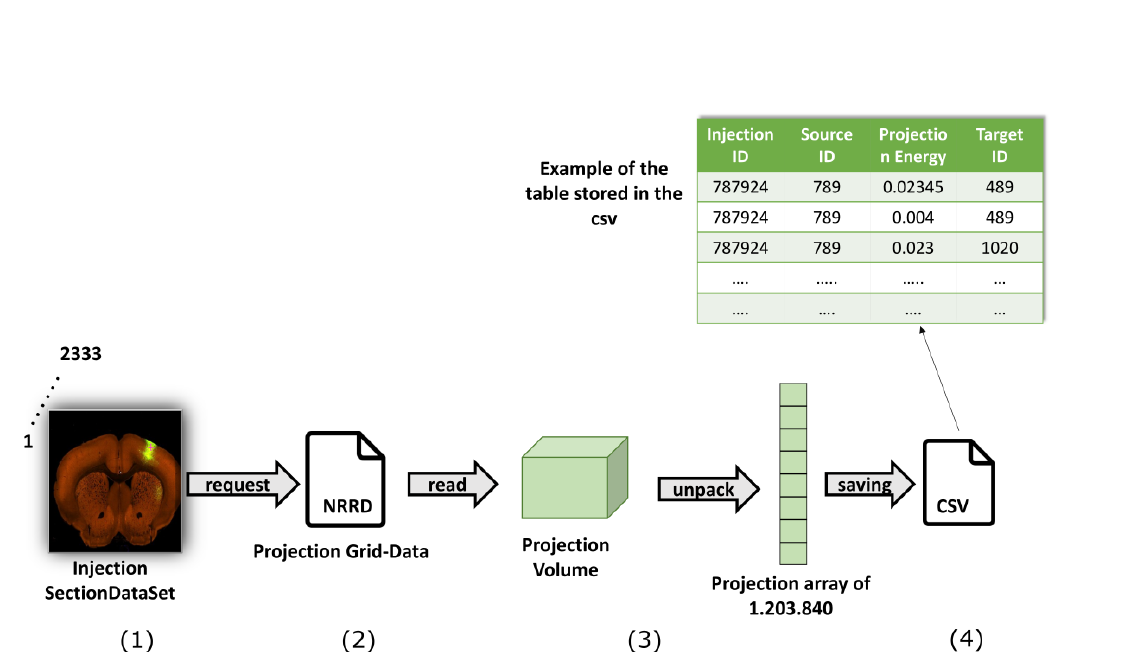
Figure 7. Elaboration of connectivity data: main phases. ( 1 ) Retrieve a SectionDataset for each of the 2333 primary injections; ( 2 ) projection grid-data in the form of an .Nrrd file; ( 3 ) reconstruct a projection volume, unpacked into a vector of 1,203,840 elements; ( 4 ) store data into a .csv